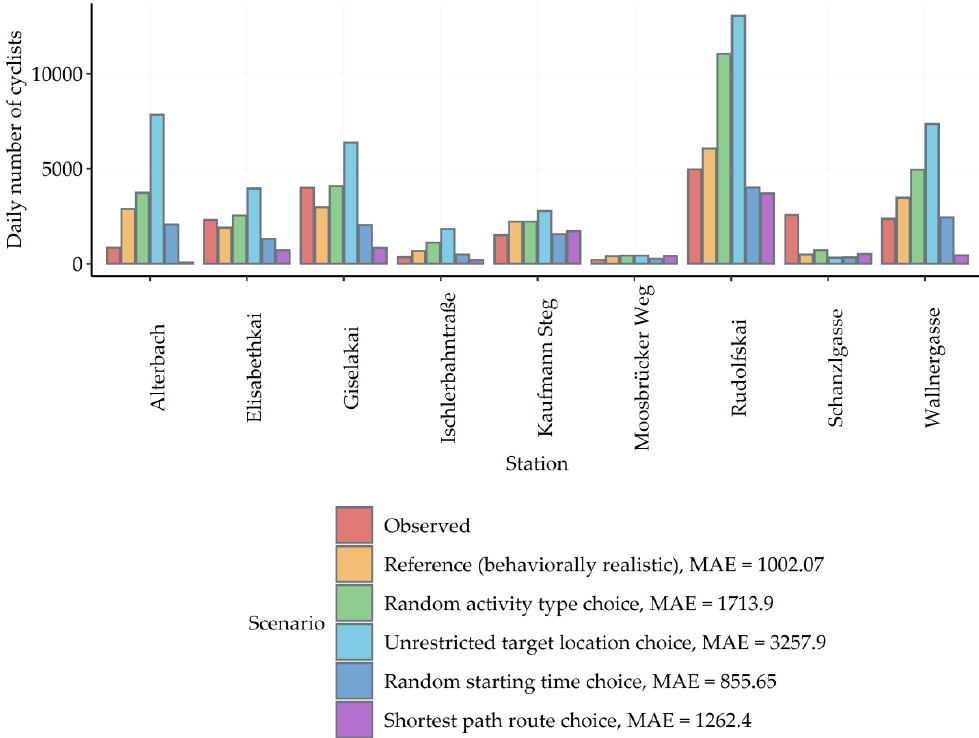
Figure 6. The daily totals of traversed cyclists at stations and the average mean absolute errors by scenario.